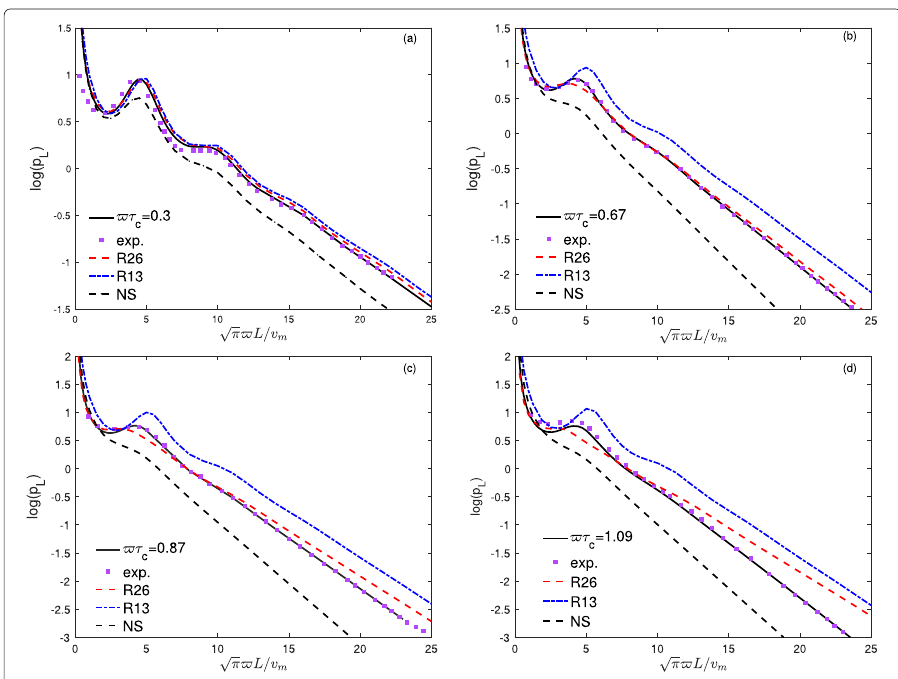
Fig. 12 Sound amplitude p L at the receiver as function of the dimensionless length normalized by p 0 u 0 / v m . Solid lines represent the accurate results from the Shakhov model (44) solved by the discrete velocity method [69], that is, doubling the number of spatial and discrete velocity points gives the same results. Solid squares (experimental data) are collected from Ref. [56] when the gas medium is helium. = μ/ p τ c 0 is the average collision time of gas